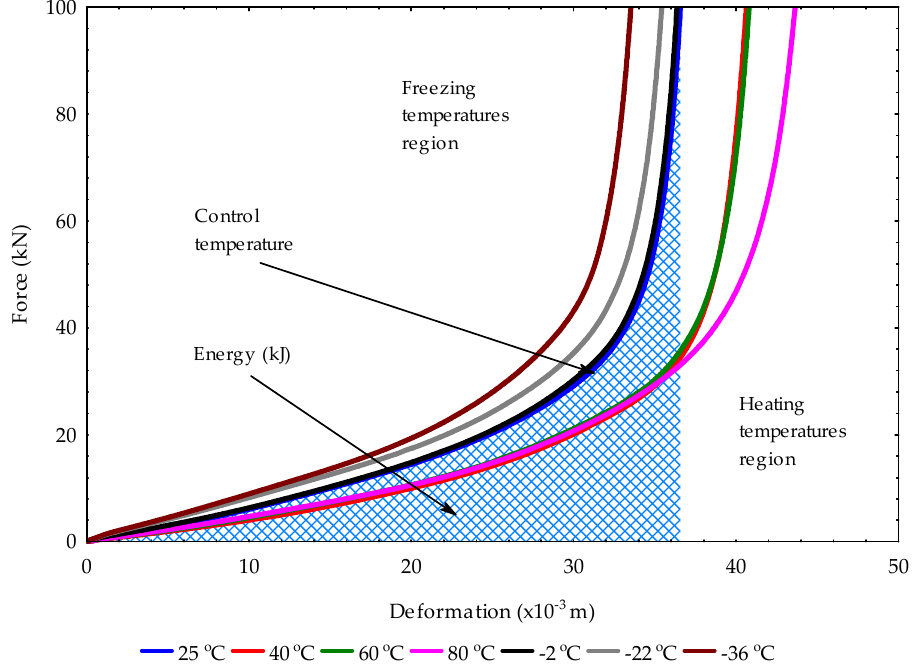
Figure 1. Force − deformation curves of rapeseed under different pretreatment conditions (tempera- ture of 25 °C served as the control).